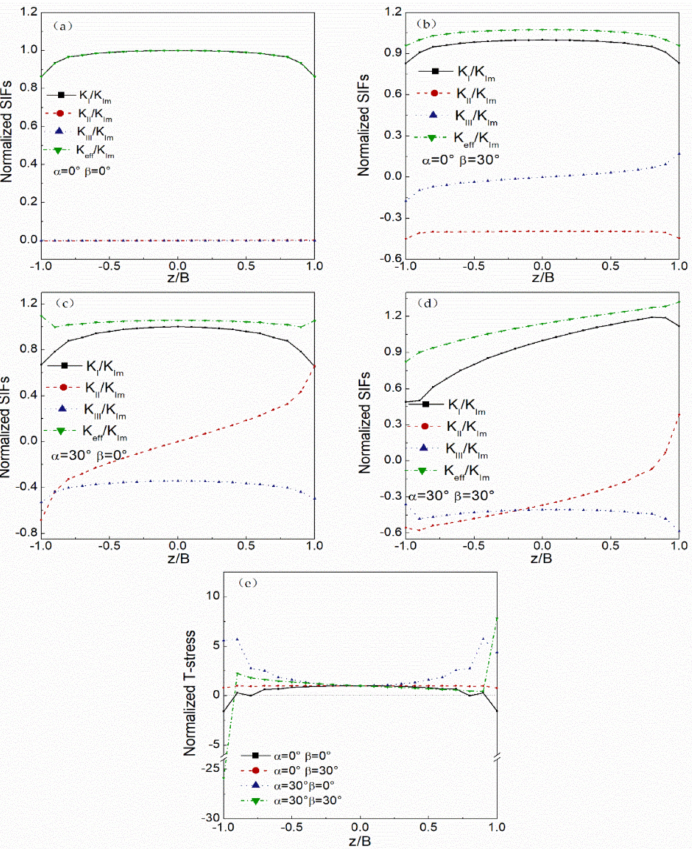
Figure 3. Variations of the normalized fracture parameters for typical crack inclined angles ( α and β ) along z/B direction. ( a ) The normalized SIFs in α = 0 ◦ and β = 0 ◦ . ( b ) The normalized SIFs in α = 0 ◦ and β = 30 ◦ . ( c ) The normalized SIFs in α = 30 ◦ and β = 0 ◦ . ( d ) The normalized SIFs in α = 30 ◦ and β = 30 ◦ . ( e ) The normalized T-stress in four groups of